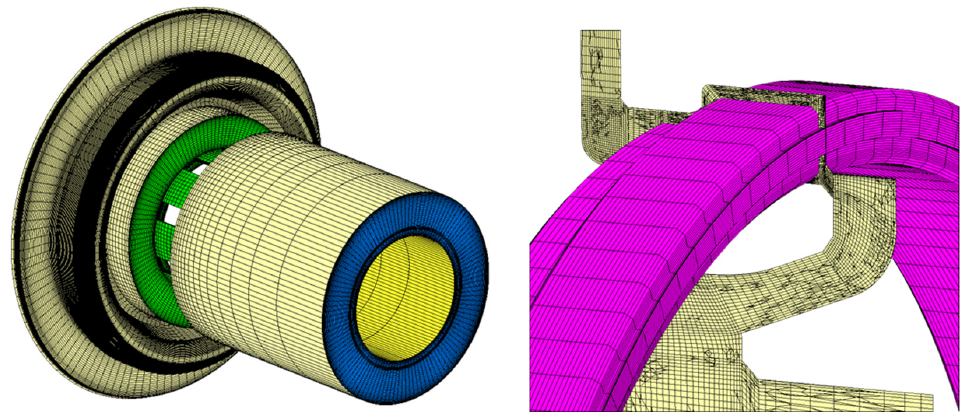
Figure 5. Grid of LOx rear floating ring and bearing cooling flow path.